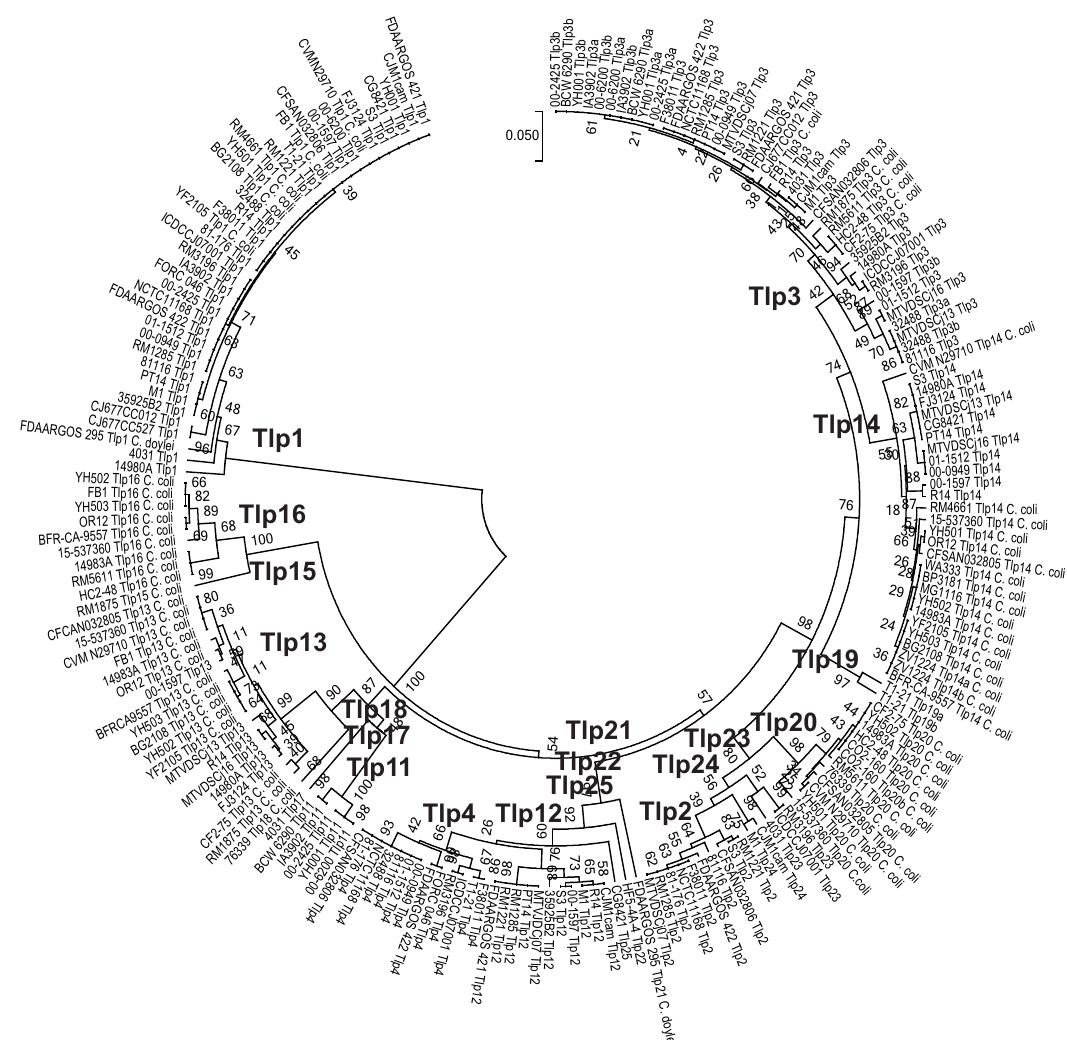
Fig 4. UPGMA dendrogram showing sequence relationships of Cj and Cc Tlps. The dendrogram was created using the data in S4 FASTA.